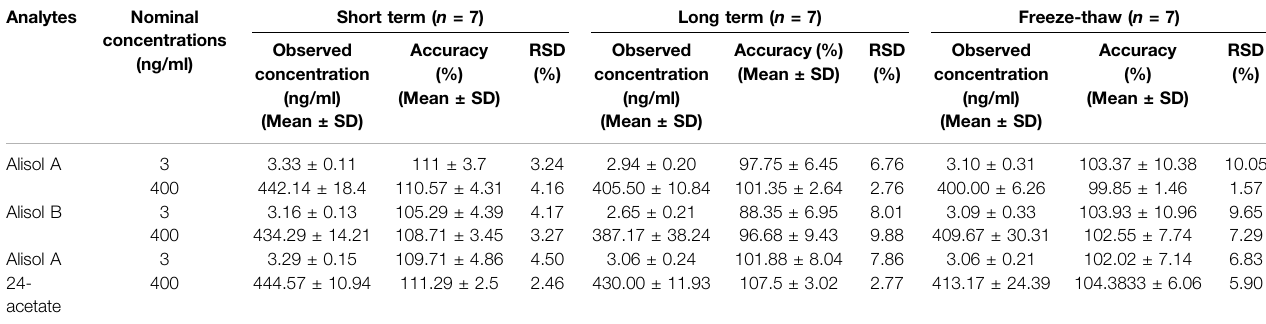
TABLE 3 | Stability of QC